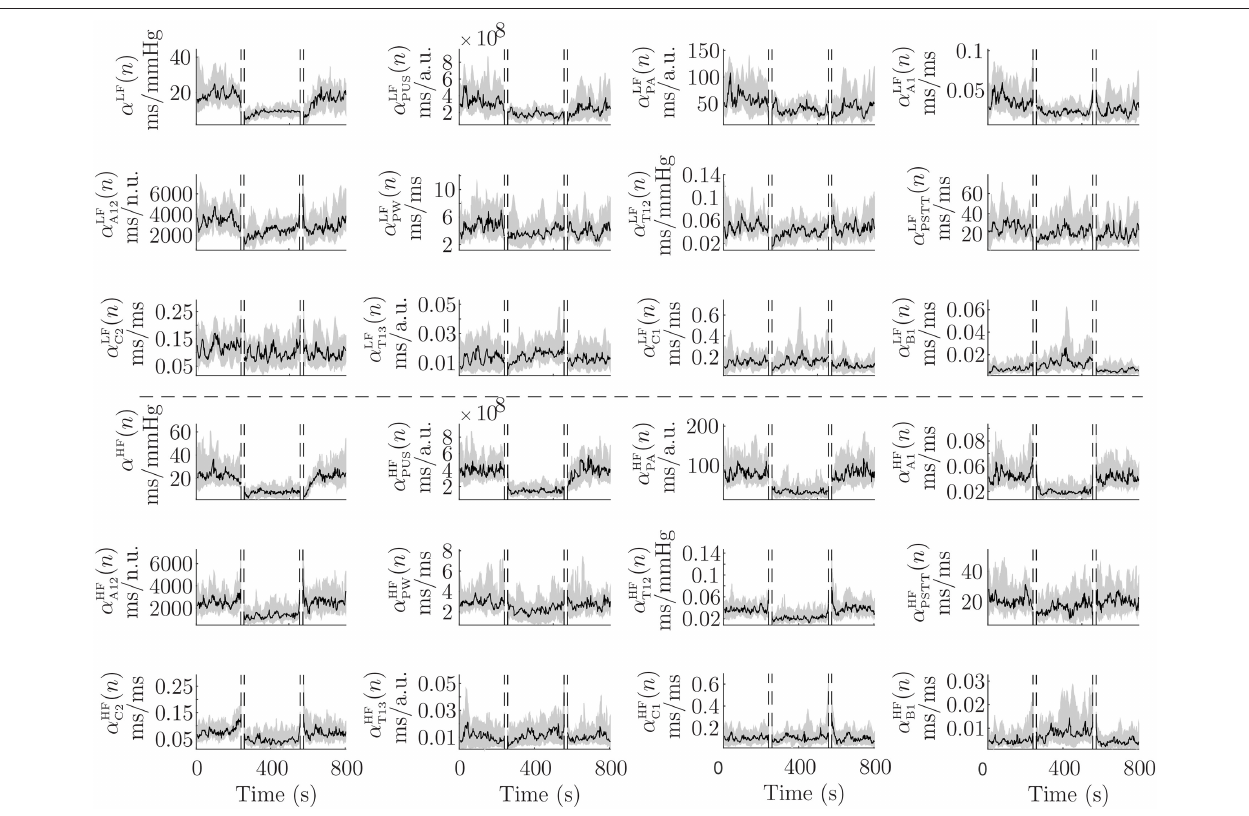
FIGURE 4 | Median (black) and IQR (shaded area) of α LF ( n ), α HF ( n ), and their PPG-based surrogates, during the whole protocol. First 3 rows are related to the LF band and last 3 rows are related to the HF band.